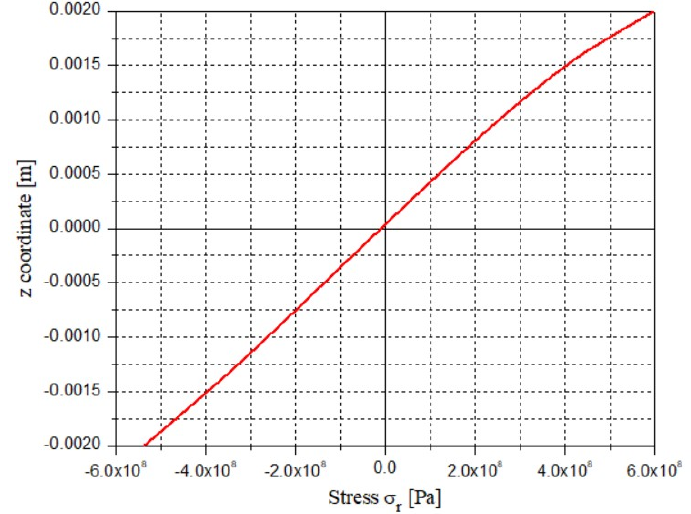
Figure 18. Nodal radial stress variation on the plate thickness, in the clamped edges.